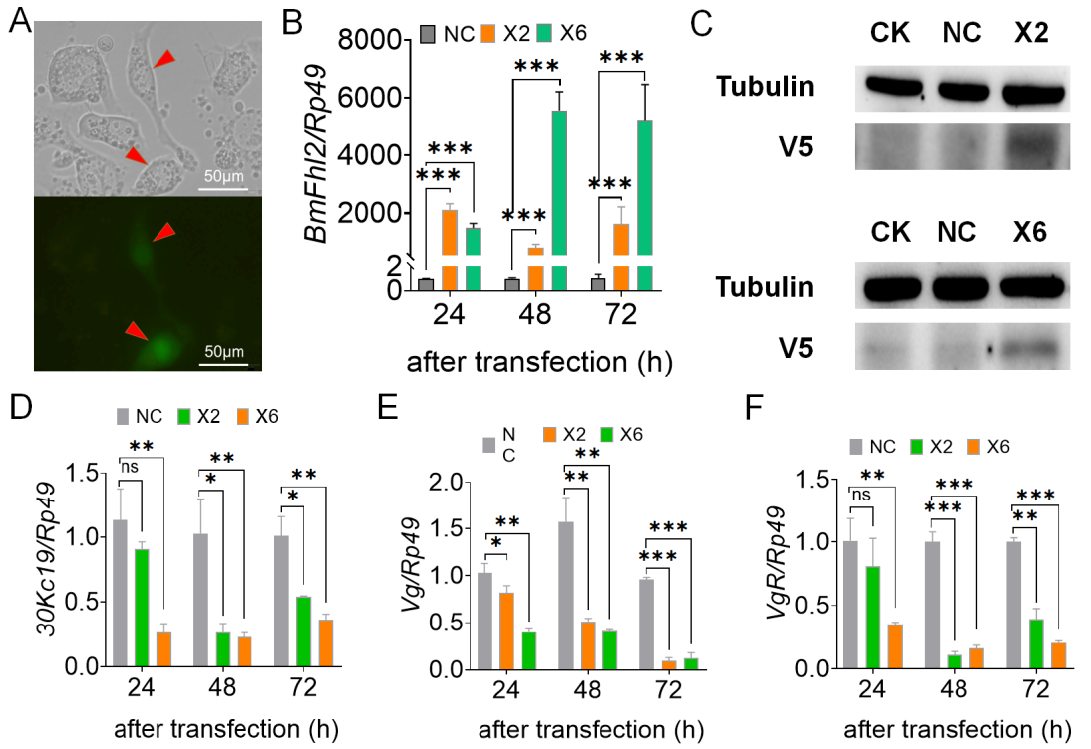
Figure 4. Effects of BmFhl2 overexpression on the egg protein-related genes. ( A ) GFP fluorescence assay after overexpression. Transgenic cells under normal light and stimulated light are shown. The red arrows indicate successfully transfected cells. ( B ) Confirmation of BmFhl2-X2 and BmFhl2-X6 overexpression in BmN cells at the transcriptional level. ( C ) WB assay was performed at 48 h after BmFhl2 overexpression. ( D – F ) qPCR analysis of the expression levels of 30Kc19 , Vg , and VgR at 24, 48, and 72 h after overexpression. *, p ≤ 0.05; **, p ≤ 0.01; ***, p ≤ 0.001; ns: nonsignificant difference. Rp49 was used as the qPCR reference gene, while tubulin was used as the WB reference protein. Mean ± SD, N = 3.